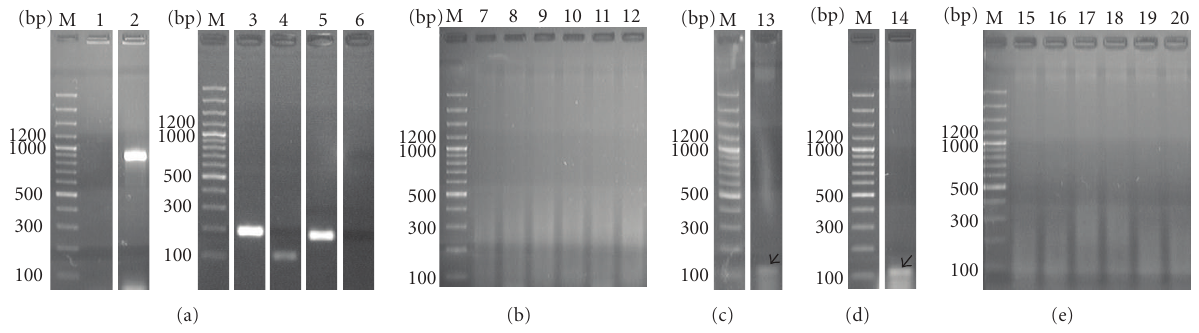
Figure 4: Electrophoregrams of amplification products for DNA nucleotide sequences of the following genes fts Z: (1, 7, 15), pdh C (2, 8, 16), pnp (3, 9, 17), tuf B (4, 10, 13, 14), rpo B (5, 11, 19), and 16S–23S rRNA (6, 12, 20) of A. laidlawii PG8 obtained at use, in PCR, total DNAs (as matrix) isolated from EMVs of A. laidlawii PG8 (a) and plant leaves grown in medium with EMVs (b and c—2 h and 9 days, resp.), the mycoplasma cells (d), and in the absence of the infect (e). Arrows indicate location of the corresponding PCR-signals. M—a marker of fragment